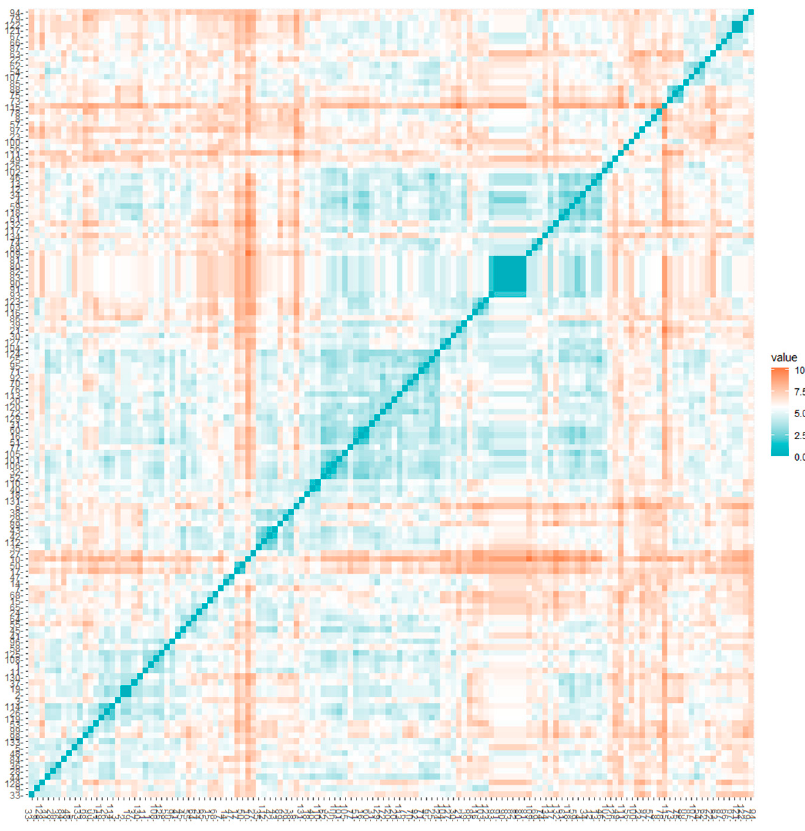
Figure 2. The matrix of distances between students’ answers.